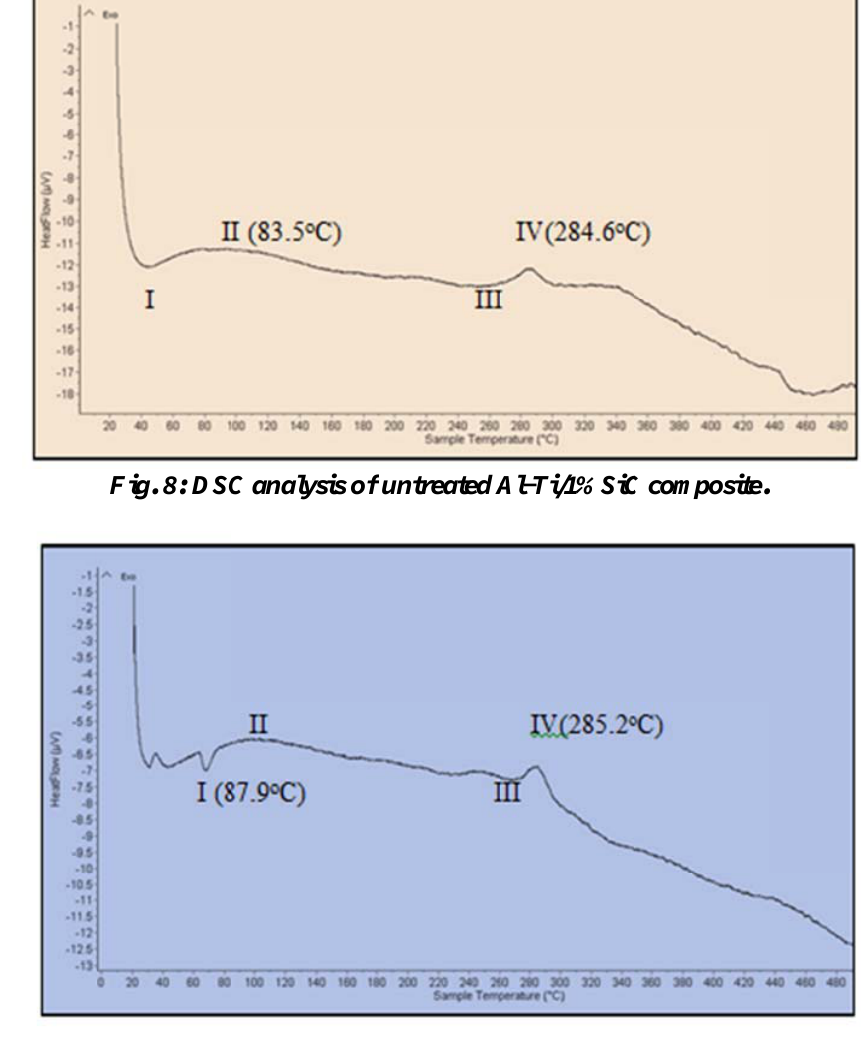
Fig. 9: DSC C analysis of